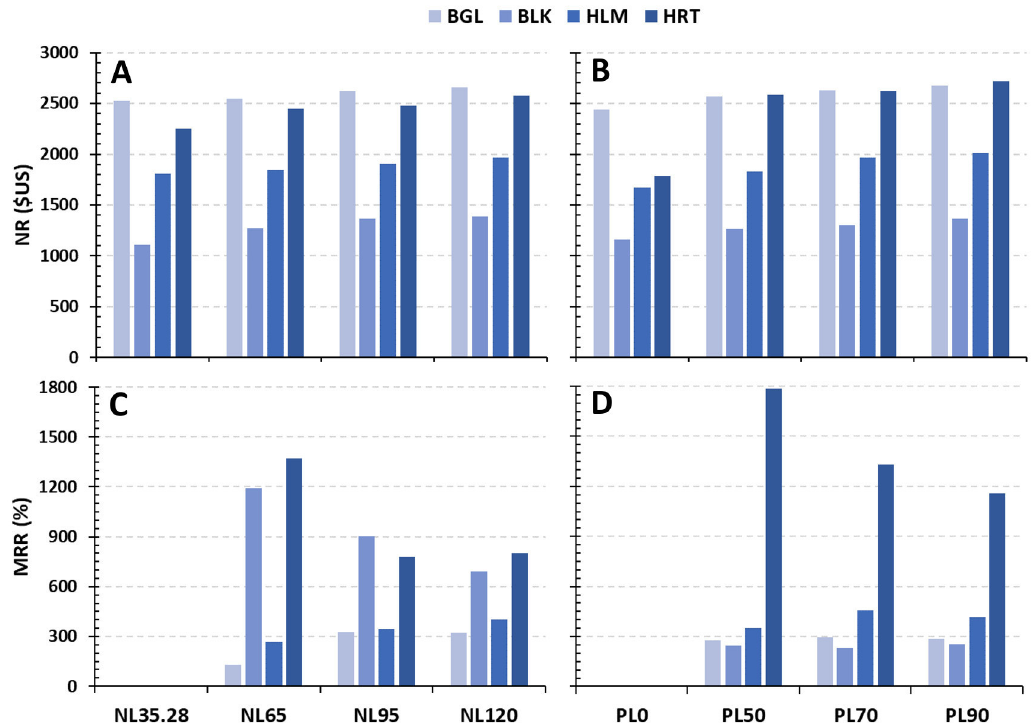
Figure 6. Partial budget analysis of bread wheat produced in relation to the application of nitrogen (NL) and phosphorus (PL). The histogram of ( A , B ) represent the net revenue (NR, $US) of NL and PL application, respectively. The histogram of ( C , D ) represent the marginal rate of return (MRR, %) of NL and PL application, respectively.